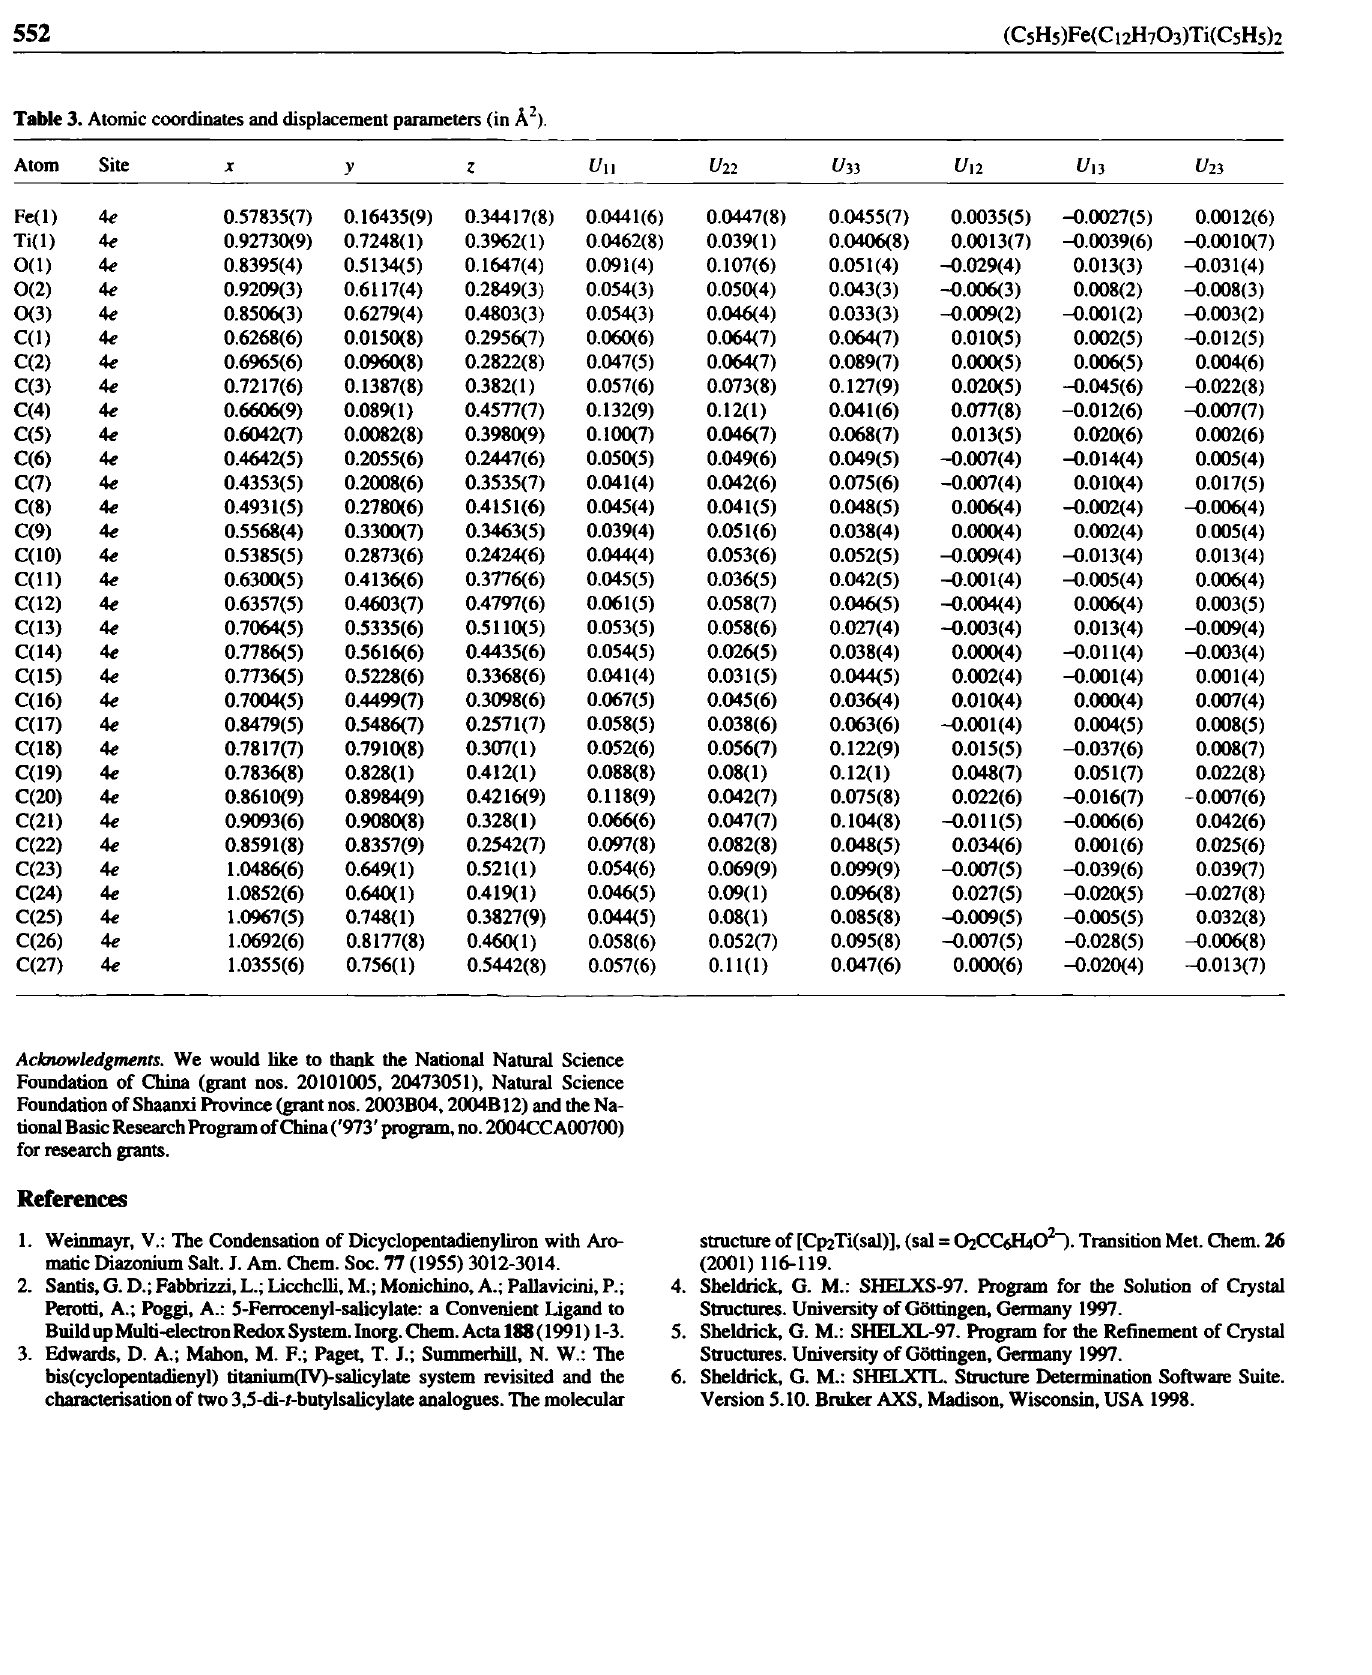
Table 3. Atomic coordinates and displacement parameters (in A 2